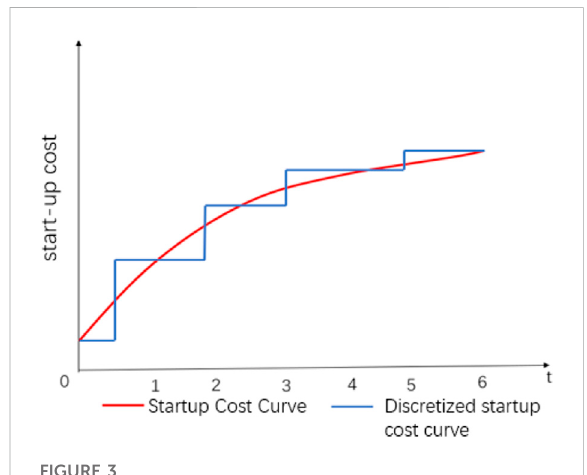
FIGURE 3 The relationship between startup cost and of fl ine